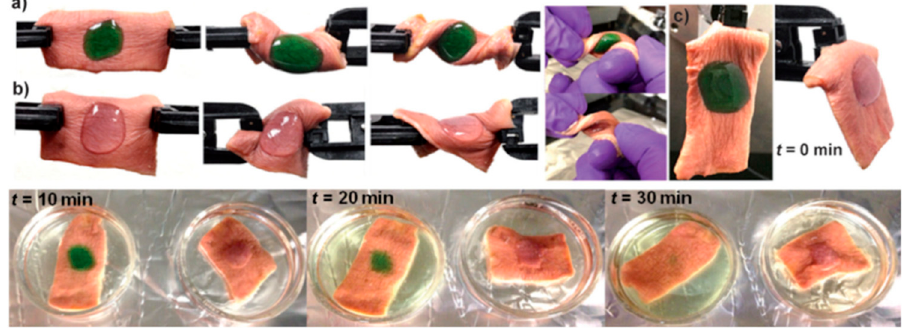
Figure 14. ( a ) Mechanical resistance of hydrogels formed by the thio-ester (green) bond; ( b ) mechanical resistance of hydrogels formed by the amide (pink) bond; ( c ) degradation of the hydrogels in the solution of L -cysteine methyl ester. From [39], Copyright © 2013 by John Wiley & Sons, Inc. Reprinted by permission of John Wiley & Sons, Inc.